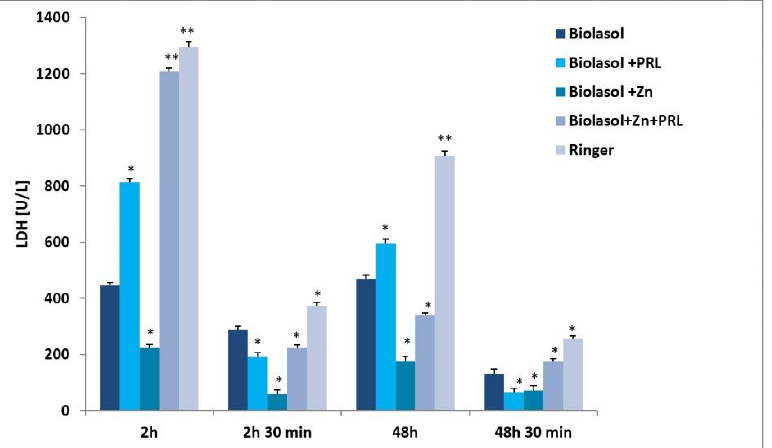
Figure 3. LDH activity in the collected perfusates and reperfusates in model of storing isolated por- cine kidneys. The values are expressed as mean ± SEM. Data were analysed by one-way ANOVA and Bonferroni post hoc tests; n = 10; * p < 0.05; ** p < 0.01 compared to the control group (Biolasol).